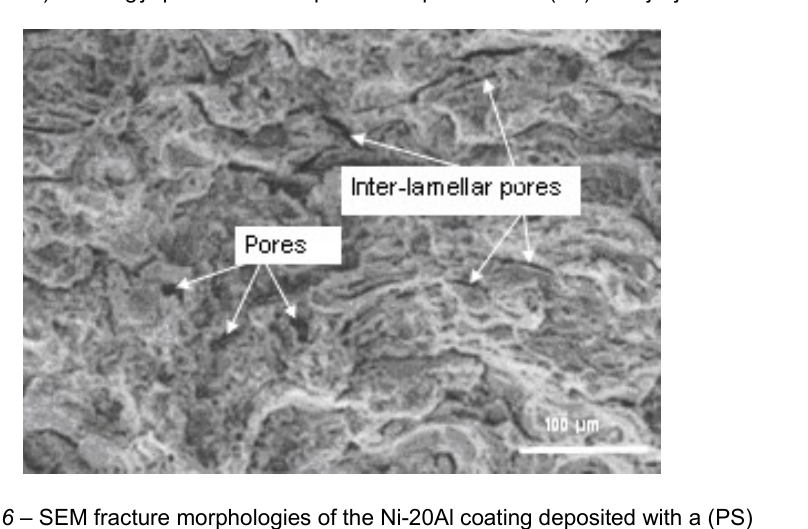
Figure 6 – SEM fracture morphologies of the Ni-20Al coating deposited with a (PS) distance of 80